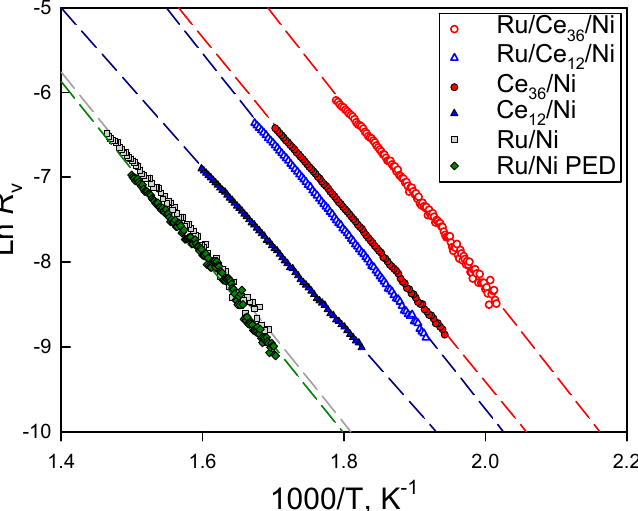
Figure 6. Arrhenius plots for the specific (volumetric) rate of CO 2 consumption during its hydro- genation over foam catalysts. Feed CO 2 /H 2 /N 2 = 1/4/5 by volume. In particular, the apparent activation energy values for CO 2 consumption measured Table 2. Apparent activation energy values for the hydrogenation of CO 2 over foam catalysts; process selectivity to CH 4 and CO 2 reaction rates at 300 ◦ C per unit volume and surface area of foam catalysts and per gram of Ru (normalized w.r.t. the value measured over Ru/Ni at the same temperature). Normalized CO 2 React. Rate Catalyst per g of Ru